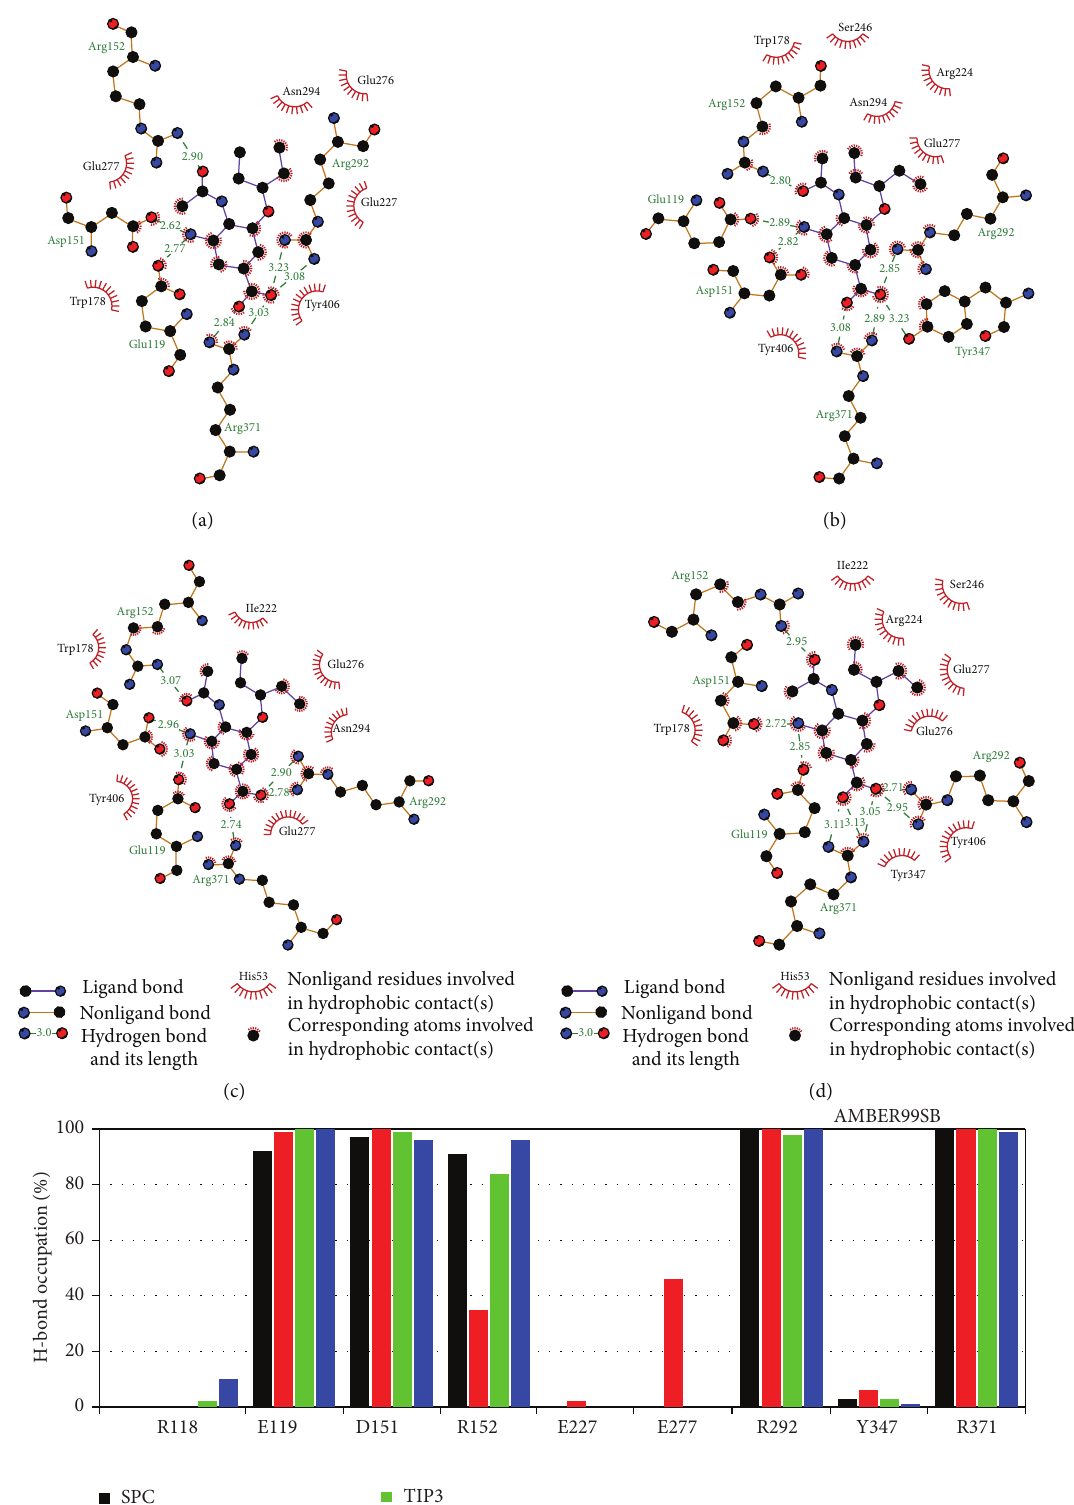
Figure 5: Typical snapshots for hydrogen bond network between Tamiflu’s charged groups and residues of NA at the binding site obtained by AMBER99SB force field with SPC (a), SPC/E (b), TIP3P (c), and TIP4P (d). Oseltamivir is hydrobonded with –COO − and –NH 2 (R371, R292); –OH (Y347); − NH 3+ and –COO − (D151, E119); NHAc and − NH 2 (R152) of NA. All hydrogen atoms are implicit. The lower panel refers to the probability of formation of HBs between ligand and receptor. The results are averaged over the last 2 ns of simulation. Black, red, green, and blue refer to SPC, SPC/E, TIP3P, and TIP4P,